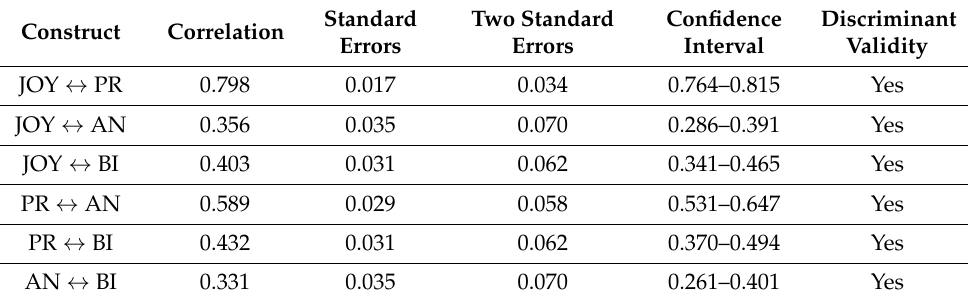
Table 10. Confidence intervals (the second wave): the confidence interval (CI) correlation of